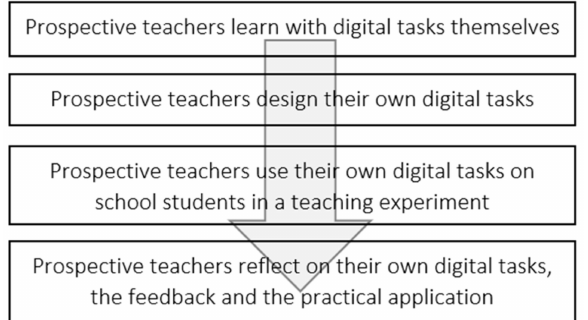
Figure 2. Seminar concept developed within this project